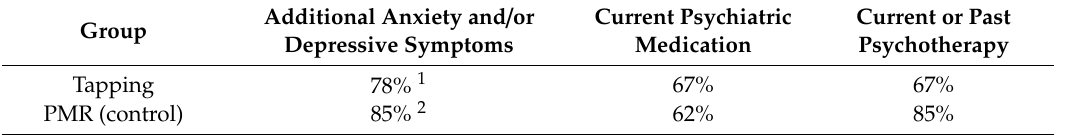
Table 2. Sample description concerning clinical characteristics (based on Diagnostisches Kurz-Interview bei psychischen Störungen (Mini-DIPS) interview and demographic questionnaire). Additional Anxiety and / or Current Psychiatric Current or Past Group Depressive Symptoms Medication Psychotherapy Tapping 78% 1 67%